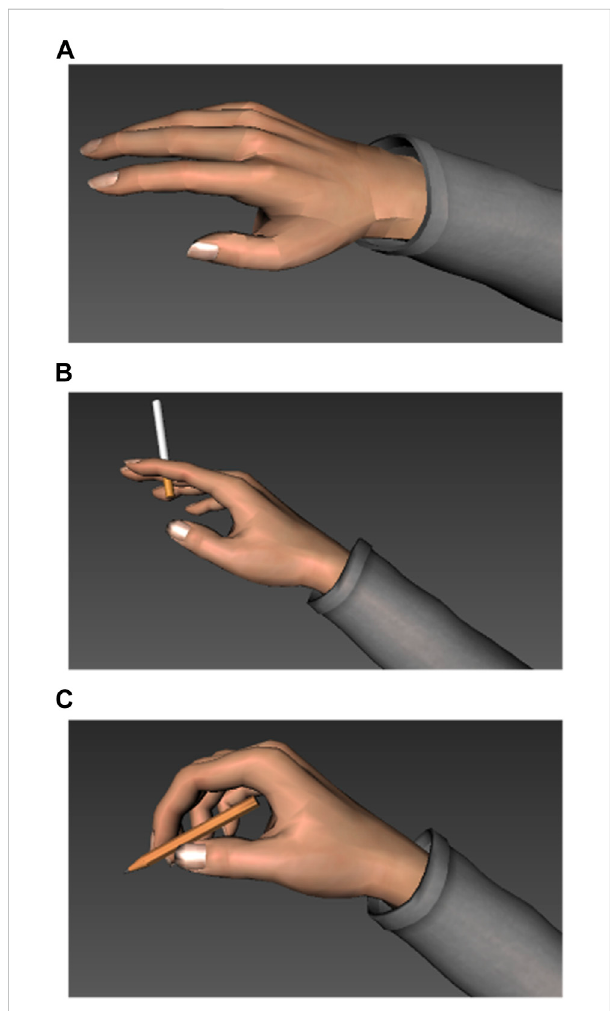
FIGURE 2 Virtual hand used in the experiment in three versions. (A) Before the initiation of the approach response without object. (B) After completion of the approach response, holding a cigarette. (C) After completion of the approach response, holding a